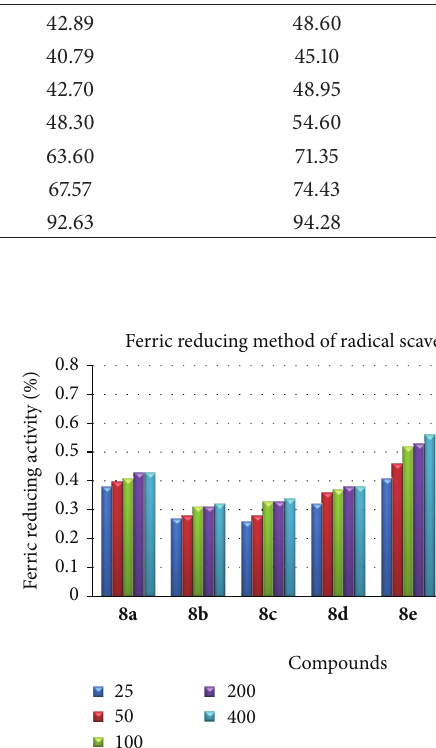
Table 3: DPPH radical scavenging activity of compounds 8(a–f) . Scavenging activity of different concentrations ( 𝜇 g/mL) of compounds % Compound